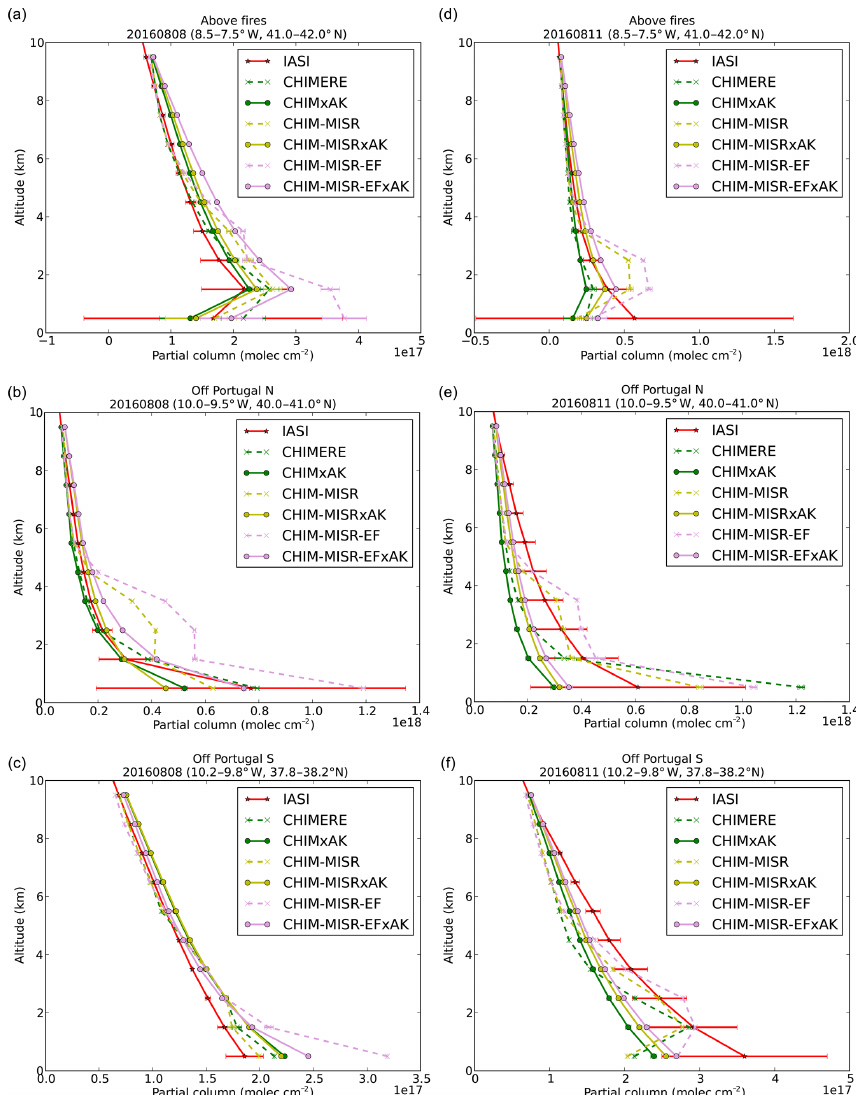
Figure 19. CO partial column profiles retrieved from IASI observations averaged over three subregions (mapped in Fig. 9) on 8 Au- gust 2016 (a–c) and 11 August 2016 (d–f) and collocated CHIMERE profiles with (solid line) and without (dashed line) smoothing by the IASI averaging kernel for three experiments: BA-sf (CHIM, green), BA-sf with the MISR injection profile (CHIM-MISR, yellow), and BA-FRP-EF with the MISR injection profile (CHIM-MISR-EF, pink). Profiles are only plotted up to 10km for clarity. Error bars correspond to the standard deviation of data used in the average, corresponding to the variability within the chosen